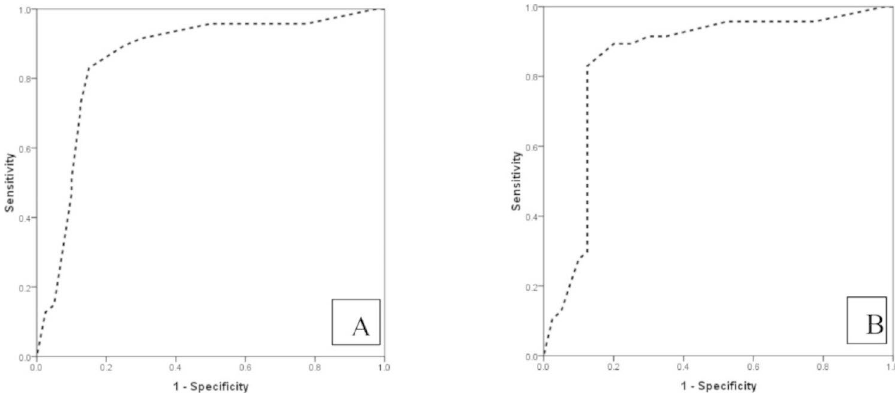
Fig. 1 The ROC curve analysis in determining the value of percentage (A) and comprehensive score (B) of Twist-1 expression in villous stromal cells for the distinction of complete from partial molar Table 2 Diagnostic accuracy of Twist-1 expression in CM and PM in cut-off value 50% for villous stromal cells and 10% for syncytiotrophoblasts